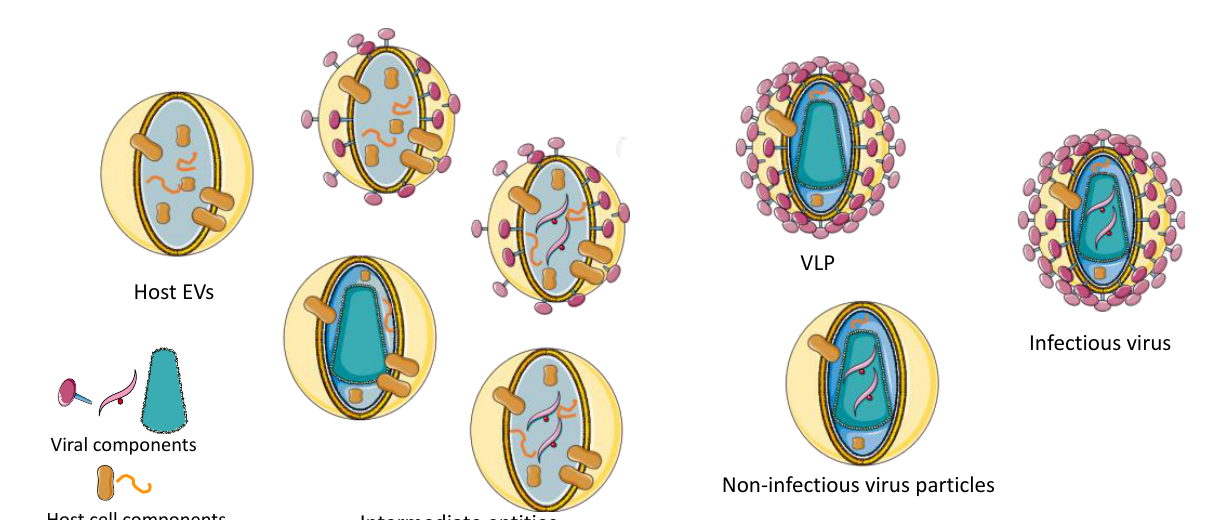
Figure 1. Expected EV, LV and intermediate entities during production of lentiviral vector (Figure created using Servier Medical Art by Servier). Viral components (left to right): envelope protein, viral genome, viral capside.